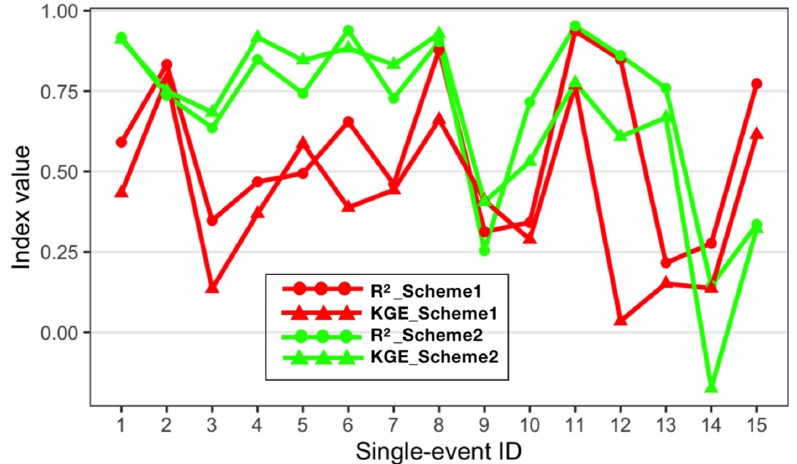
Figure 5. Comparison between observed and simulated streamflow with calibration scheme 1 versus scheme 2. The dashed blue box highlights significant improvements of base-flow simulation from scheme 1 versus scheme 2.